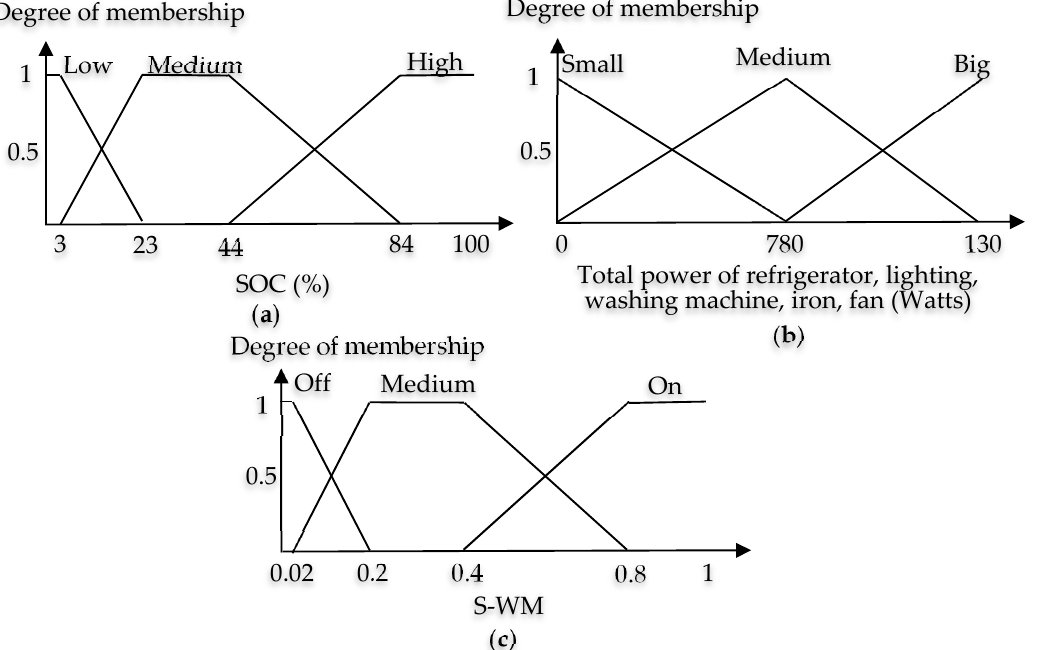
Figure 12. GAFLC membership functions of FLC-WM: ( a ) membership function of the SOC variable; ( b ) membership function of the total power of the refrigerator, lighting, washing machine, iron, and fan variables; ( c ) membership function of the S-WM variable.